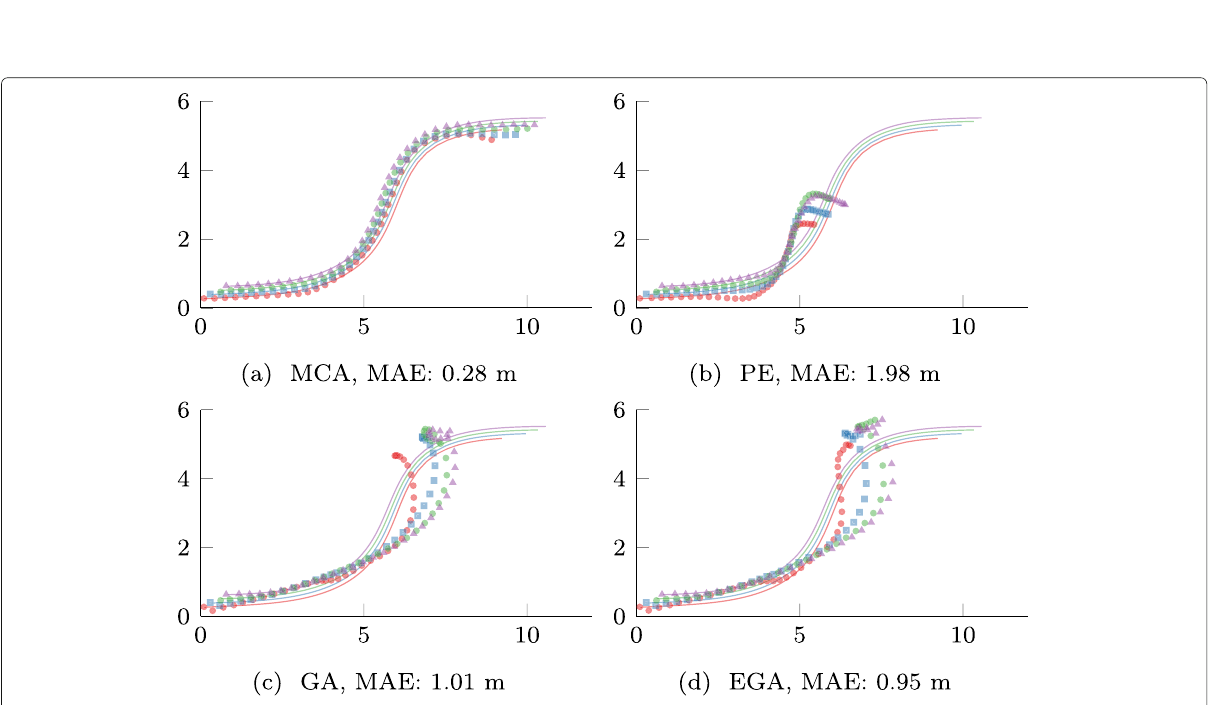
Fig. 13 Average estimated positions (markers) and actual trajectories (solid lines) in the case of M = 4 agents and for 1500 PPA. a MCA, MAE 0.28 m. b PE, MAE 1.98 m. c GA, MAE 1.01 m. d EGA, MAE 0.9